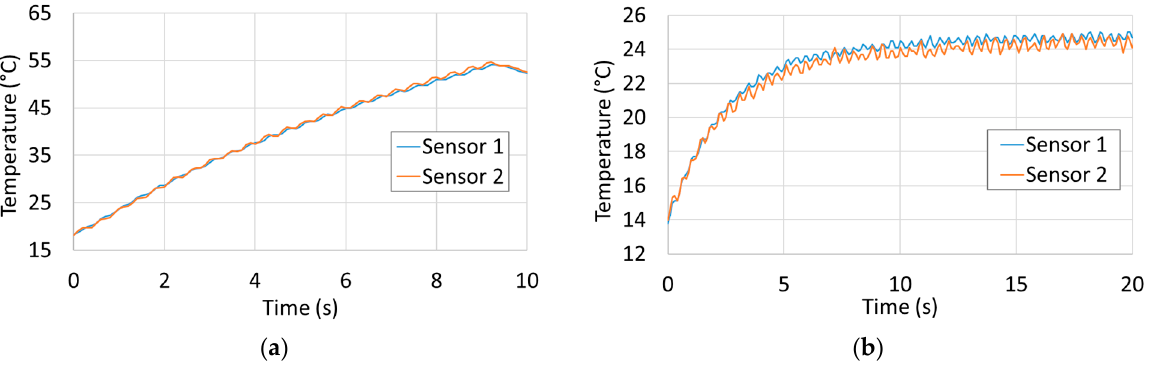
Figure 19. Temperature measurements for Inconel 625, UHCF specimen: ( a ) Maximum stress = 300 MPa, t on = 0.2 s, t off = 0.2 s, 23 pulses; ( b ) Maximum stress = 300 MPa, t on = 0.2 s, t off = 0.2 s, compressed air cooling, approximately 50 pulses.